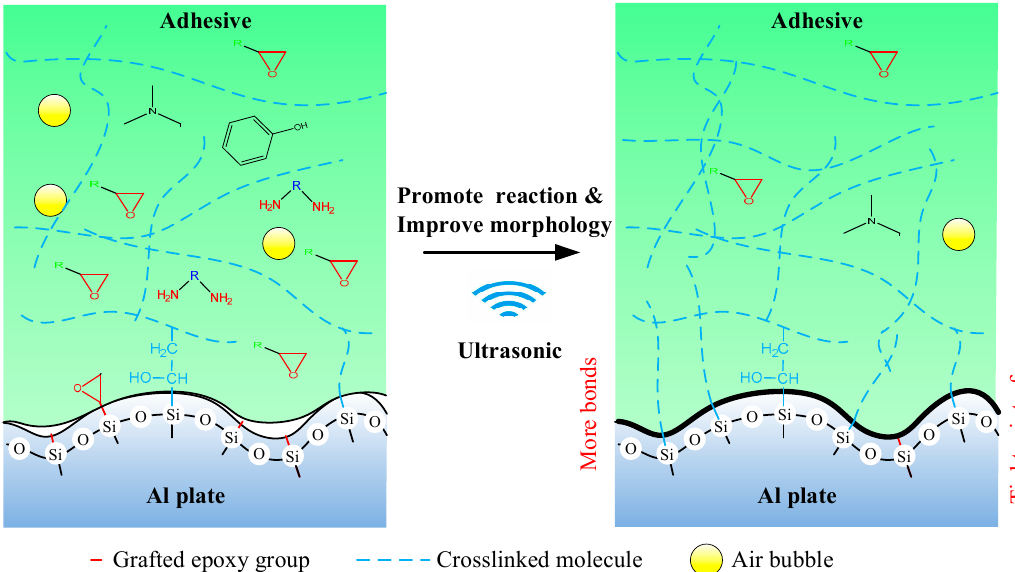
Figure 17. Mechanism of the ultrasonic assisting.